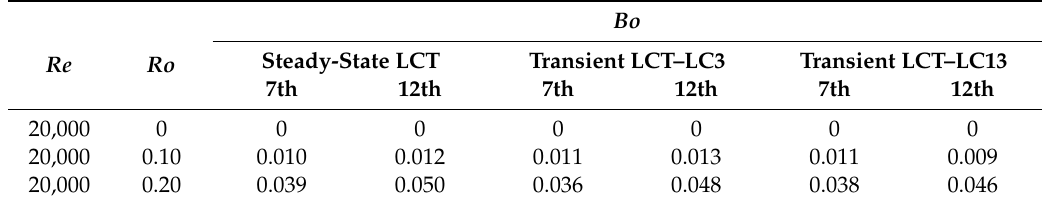
Table 1. Averaged buoyancy number over 7th and 12th inter-ribs for all tests conditions. Bo Steady-State LCT Transient Re Ro